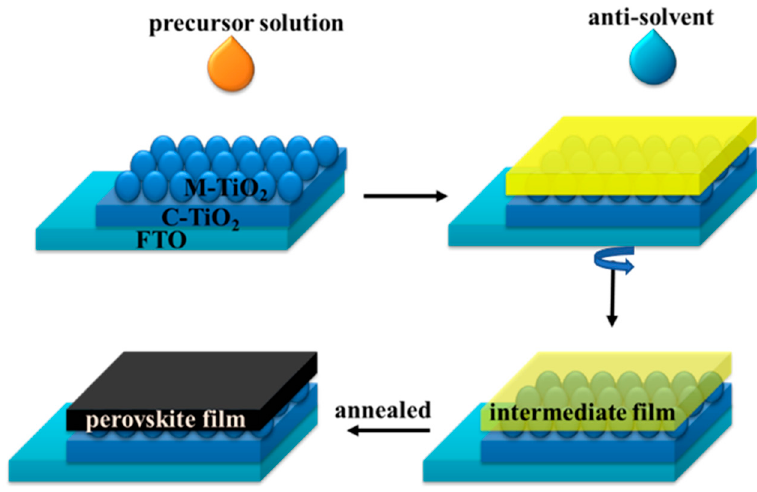
Figure 2. Schematic illustration of the perovskite film fabrication.